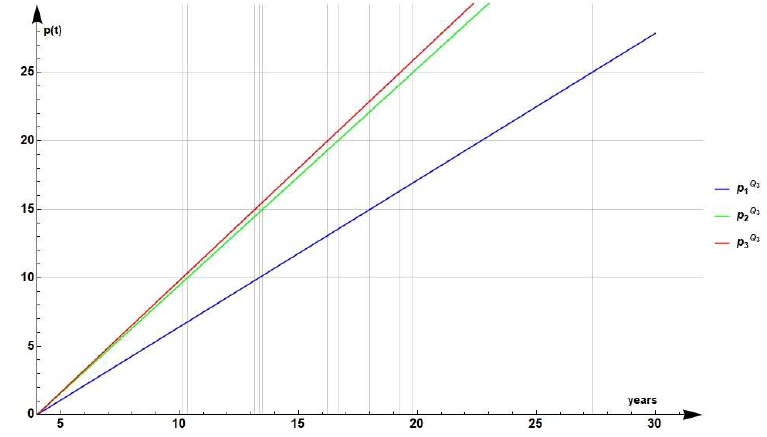
Figure 4. The critical values of the maximum wear percentage—of LG.